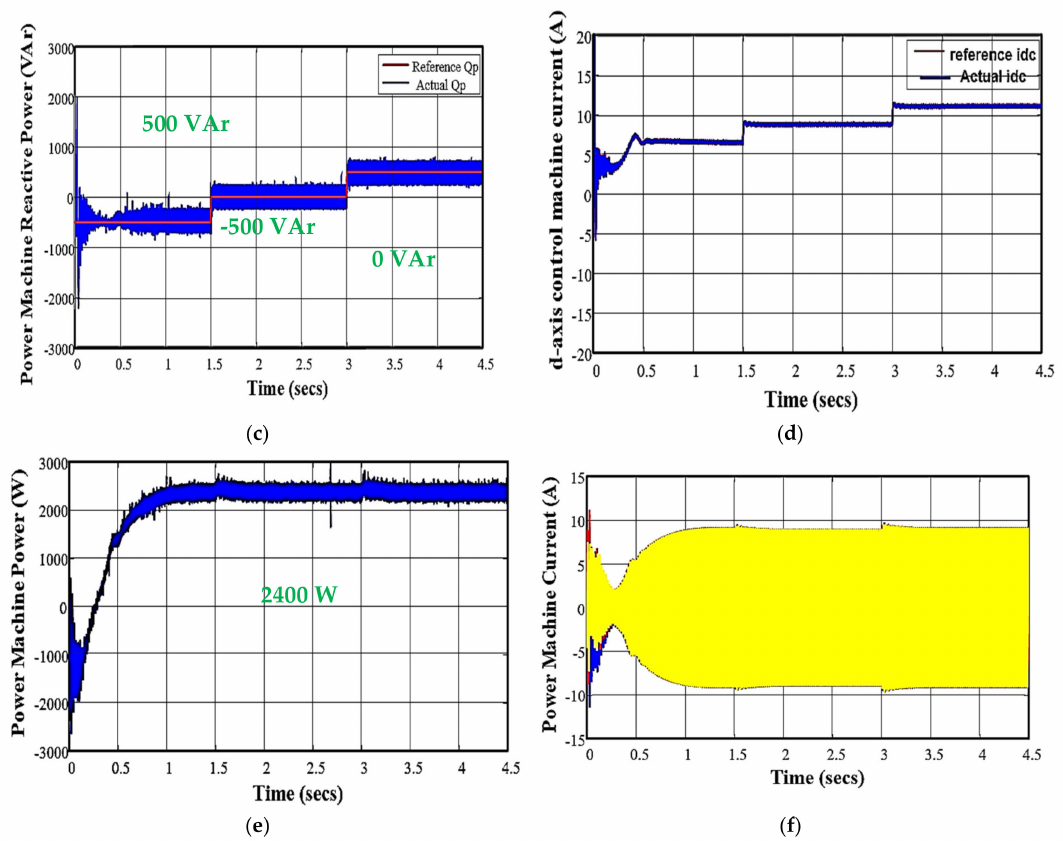
Figure 11. System performance under constant speed command and variable reactive power reference: ( a ) rotor speed, N m (rpm), ( b ) control machine q -axis current reference and actual, i qc * and i qc , ( c ) power machine reactive power, Q p , ( d ) control machine d -axis current reference and actual, i dc* and i dcr , ( e )